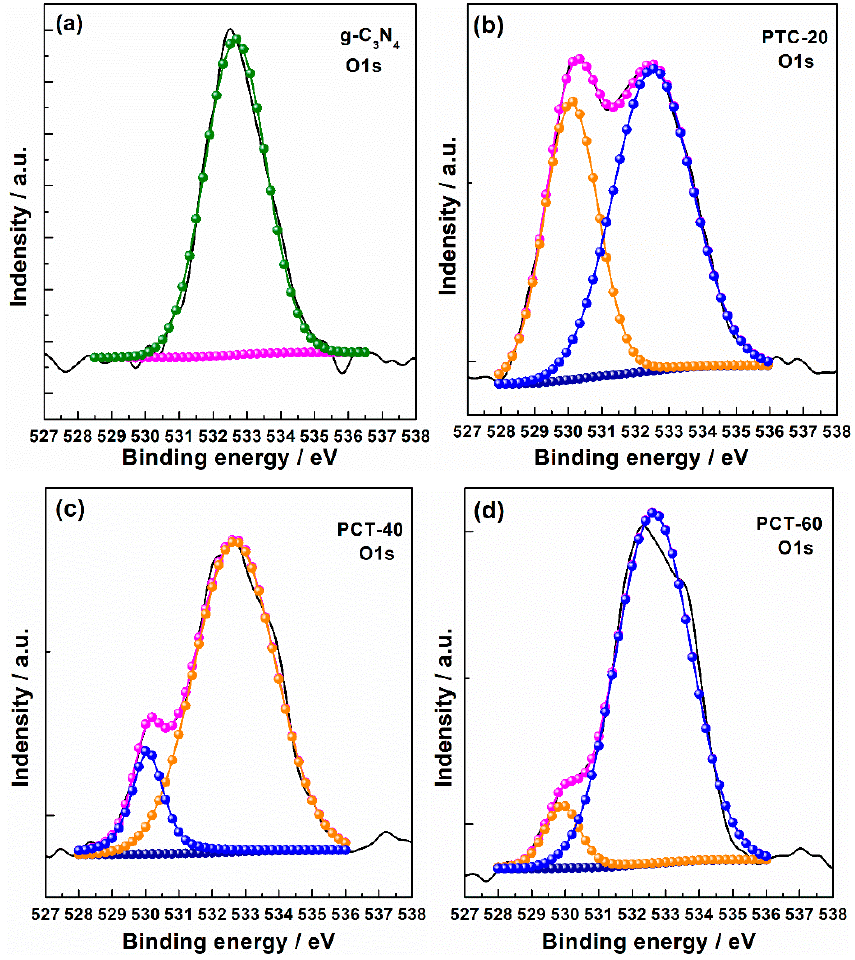
Figure 6. FittedO1sXPSspectraof( a )layeredg-C 3 N 4 , ( b )PTC-20, ( c )PTC-40and( d )PTC-60, Figure 6. Fitted O1s XPS spectra of ( a ) layered g-C 3 N 4 , ( b ) PTC-20, ( c ) PTC-40 and ( d ) PTC-60, respectively.